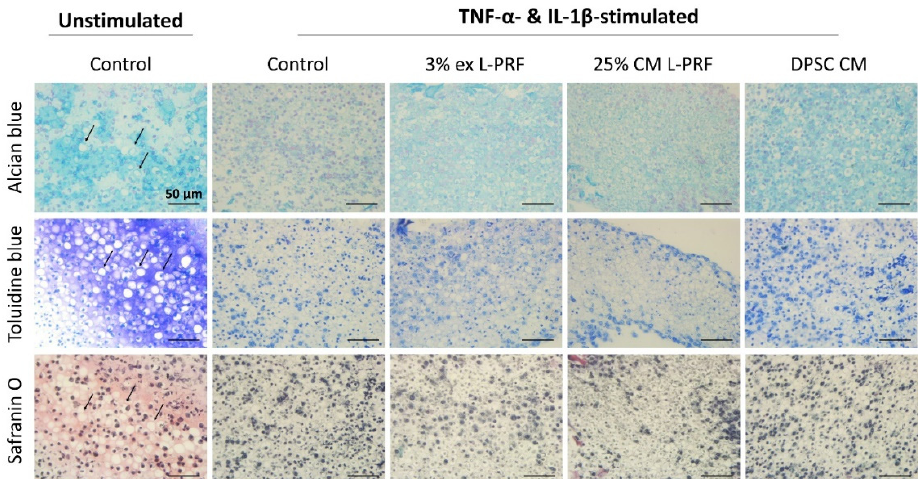
Figure 6. TNF- α - and IL-1 β -stimulated iMACs cultured in 3D pellets attenuated a more cartilage-like morphology after exposure to L-PRF ex, L-PRF CM and DPSC CM. Representative images showed that unstimulated iMAC pellets generated a cartilage-like tissue with large numbers of chondrocytes present in lacunae (arrowheads). In the cytokine-stimulated control condition, iMACs developed into a more fibrous tissue in which cartilage-lacunae were less evident and GAG production is meaningfully reduced, as shown by an apparent decrease in alcian blue, toluidine blue and safranin O staining intensity. Cartilage lacunae were more preserved by L-PRF ex, L-PRF CM and DPSC CM with a weak tendency of improved ECM content and chondrocyte status compared to the stimulated control. Data correspond to n = 3. Scale bars = 50 μ m.